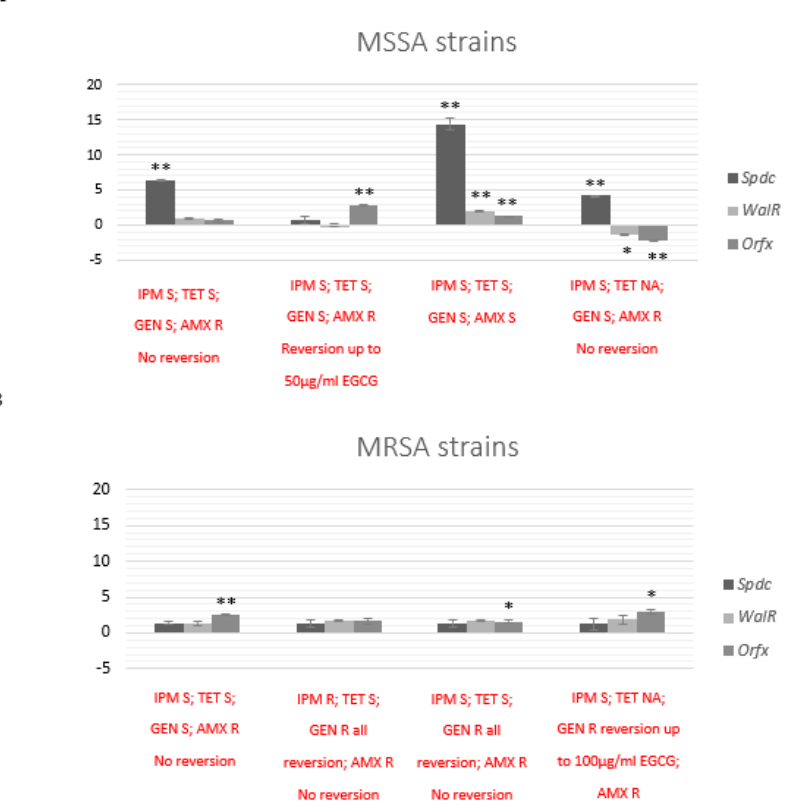
Figure 3. Graphic representation of qRT-PCR analysis of selected MSSA ( A ) and MRSA ( B ) strains after EGCG exposure. Data are representative of the relative expression for the analyzed genes, OrfX , SpdC and WalKR . 16S rRNA was utilized for normalization. Error bars represent the standard deviation between independent treatments and qRT-PCR replicates. We compared the most resistant strains calculated with Student’s t -test, for significant statistical values, which were are illustrated as: * p < 0.01 and ** p < 0.001.